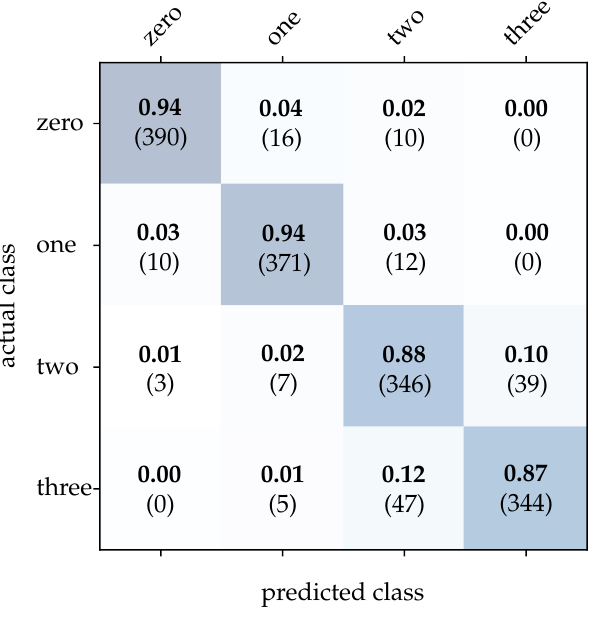
Figure 12. Classification results using HATS and the wooden balls dataset. The bold values denote the relative frequency, the number in brackets the absolute number of